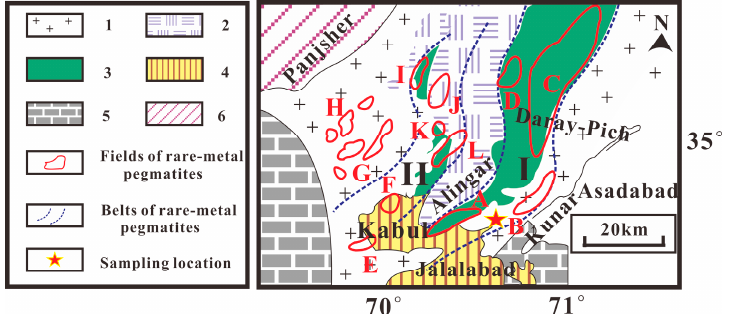
Figure 1. Geological sketch map modified from Rossovskiy and Chmyrev [20]: 1. Nuristan median massif Gneisses, crystalline schists, and marmorized limestones; 2. Lower Cretaceous-Paleogene pegmatite-bearing intrusive Laghman complex. Biotite and two-mica granites, biotite-hornblende granites, granodiorites, and quartz, rliorites; 3. Vakhan zone; 4. Neogene-Quatemary deposits. Sands. gravels, and clays; 5. Baluchistan-Himalayan fold region with a superimposed Alpine geosynclinc; 6. North Pamir Hercynian fold region. Karakorum-South Pamir Cimmerian-Alpine fold region. Belts of rare-metal pegmatites: (I) Nuristan; (II) Hindu Kush. Fields of rare-metal pegmatites: (A) Daray-Nur. (B) Chauki. (C) Parown. (D) Kantiwa. (E) Shahidan. (F) Shamakat. (G) Daram-Daram. (H) Pachagan. (I) Mundol. (J) Nilau-Kulam. (K) Kurgal. (L) Alingar.